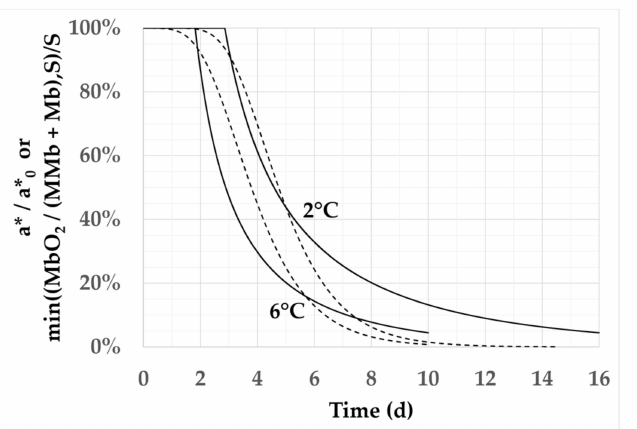
Figure 4. Impact of temperature on the model outputs. Comparison of the results of the phenomeno- logical model (dashed lines) and the reaction–diffusion model with S = 2 and Ea = 32.5 kJ/mol (solid lines) at 20% O 2 and T = 2 ◦ C and 6 ◦